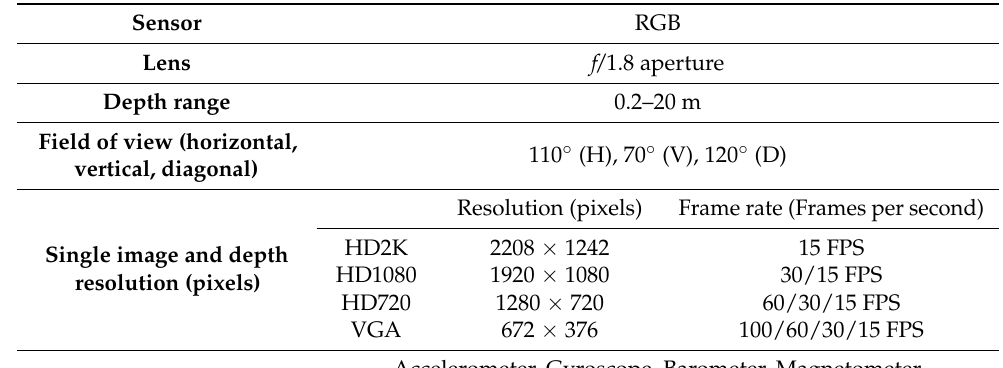
Table 1. Main characteristics of ZED camera used in the